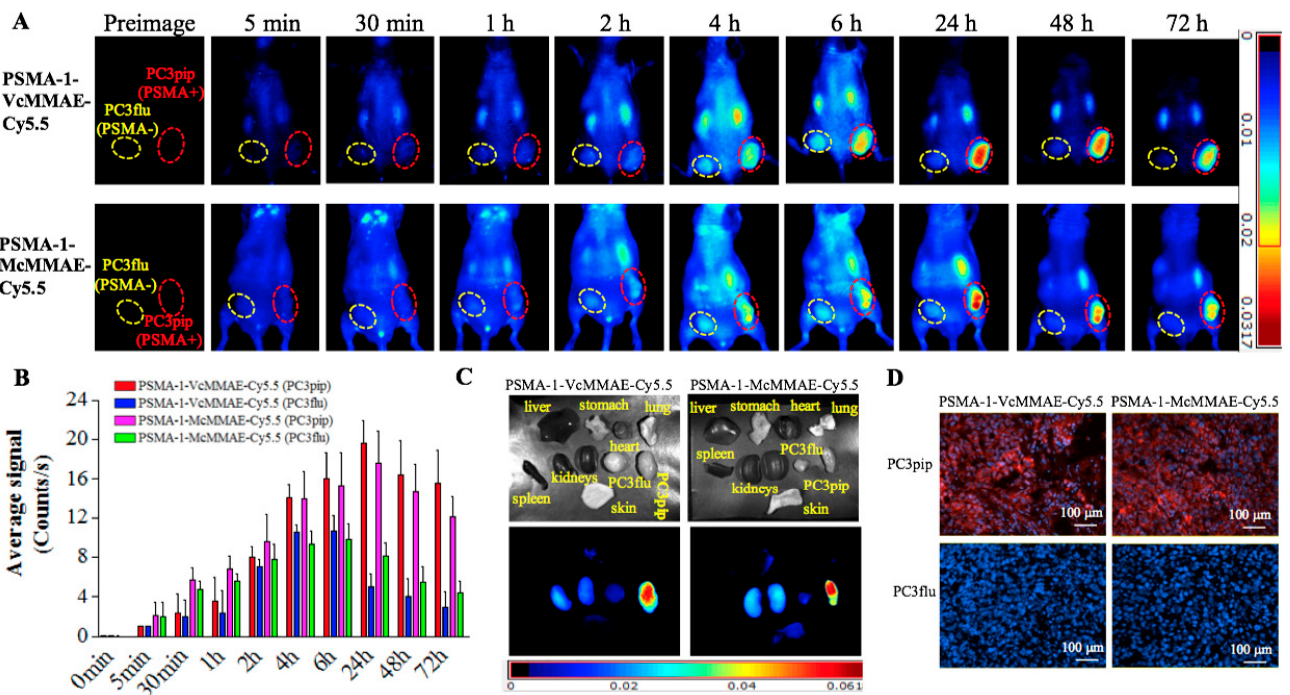
Figure 4. In vivo fluorescence image of PSMA-1-MMAE-Cy5.5. ( A ) In vivo Maestro imaging of a typical mouse bearing heterotopic PC3pip and PC3flu tumors treated with 40 nmol/kg of drug conjugates through i.v. injection. Representative images are shown of n = 5. Selective uptake was observed in PC3pip tumors. ( B ) Quantification of fluorescent signal intensity in PC3pip and PC3flu tumors. Values are mean ± SD of five animals. ( C ) Ex vivo imaging of mouse organs at 72-h post-injection. Fluorescent signal in PC3pip tumor was significantly higher than in other organs. Representative images are shown of n = 5. ( D ) Representative fluorescence images of sectioned tumors. DAPI is false colored blue and Cy5.5 is false colored red. Cy5.5 fluorescence signal was observed in PC3pip tumors ( n =